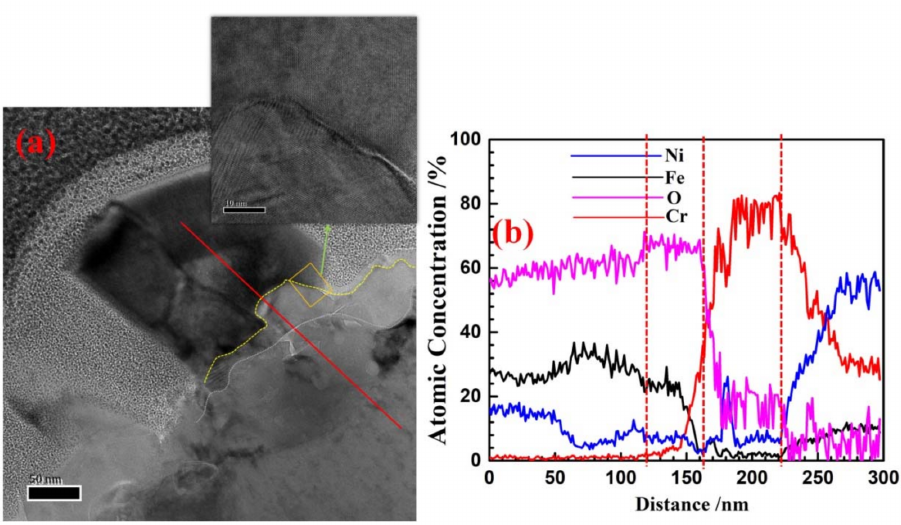
Figure 8. ( a ) TEM image of the cross-section of the oxide in position 2 of the SG tube. The boundaries are marked by the dotted lines; the inset is the magnified region of the rectangle. ( b ) EDS line scan profile of the oxide in ( a ) marked as the red